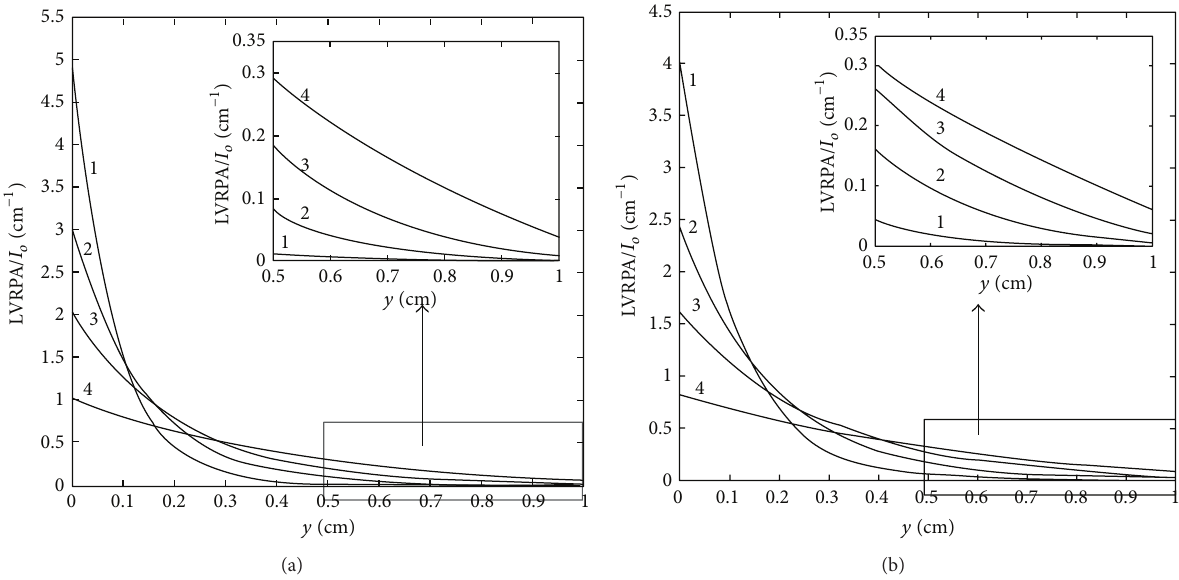
Figure 2: Profile of energy absorption rate (LVRPA /𝐼 0 ) through fluid ( 𝑦 -coordinate) for Degussa P-25 (a) and Aldrich (b). Catalysts loading (g ⋅ l −1 ): line 1 = 0.5; line 2 = 0.3; line 3 = 0.2; line 4 = 0.1.